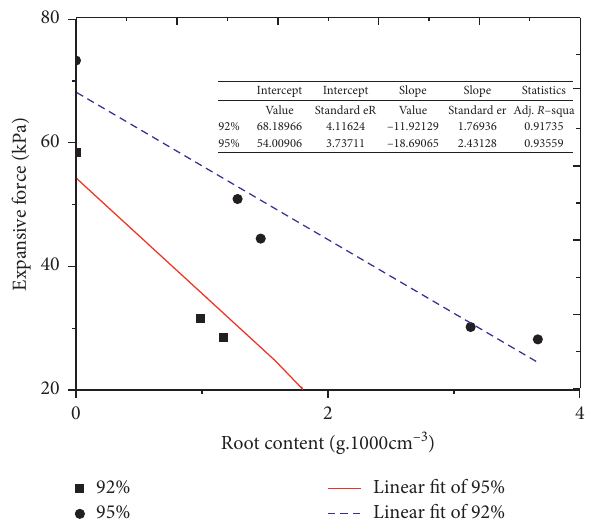
Figure 8: Relationship between expansive force and root